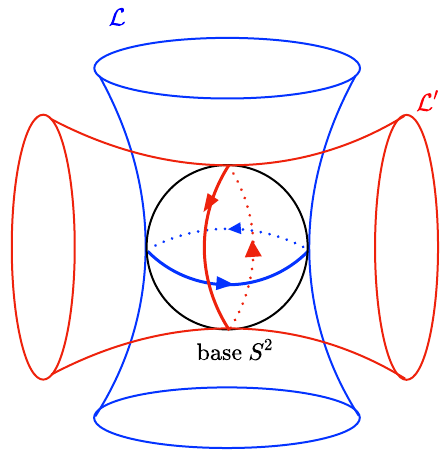
Figure 10 . D-branes on L 0 intersect with D-branes on L